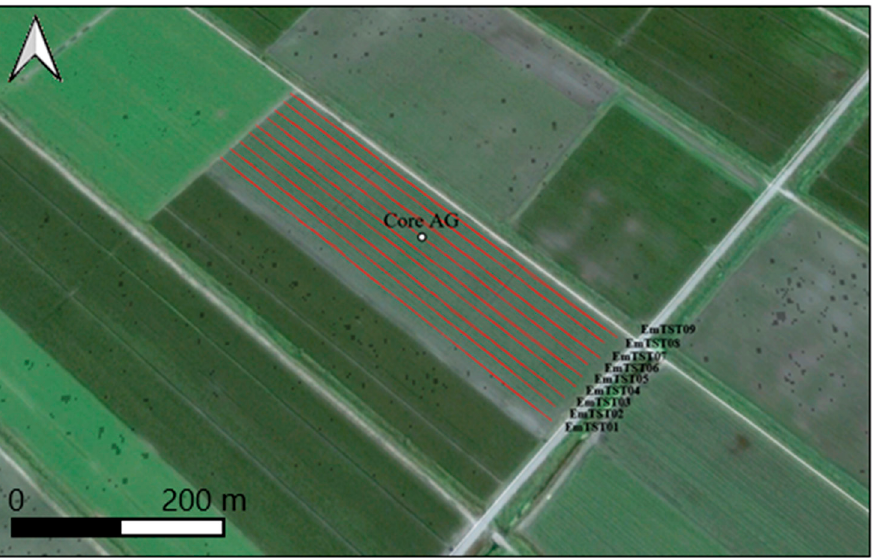
Figure 2. Studied area with the location of the nine profiles scanned with the EMP-400 profiler and the location of core AG (4 m total length).